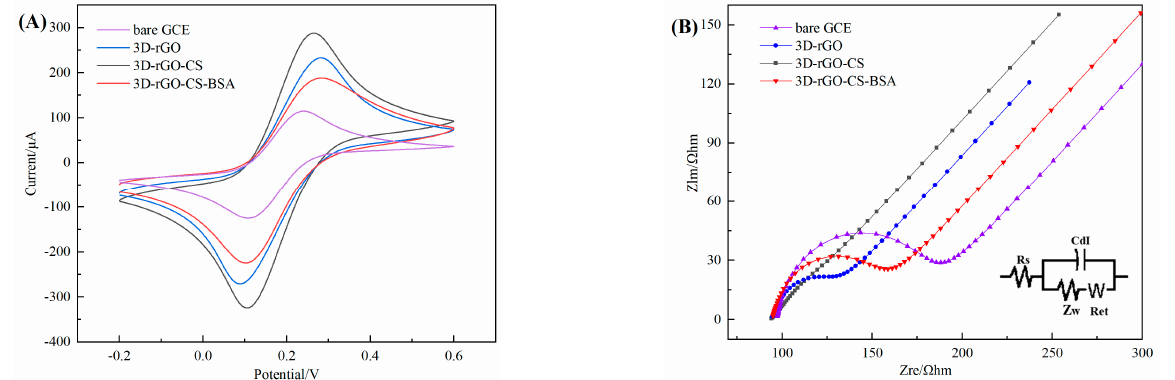
Figure 5. ( A ) CV and ( B ) EIS of bare GCE,3D–rGO,3D–rGO–CS,3D–rGO–CS–BSA in 0.1 M KCl containing 5 mM [Fe(CN) 6 ] 4 − /3 − solution.